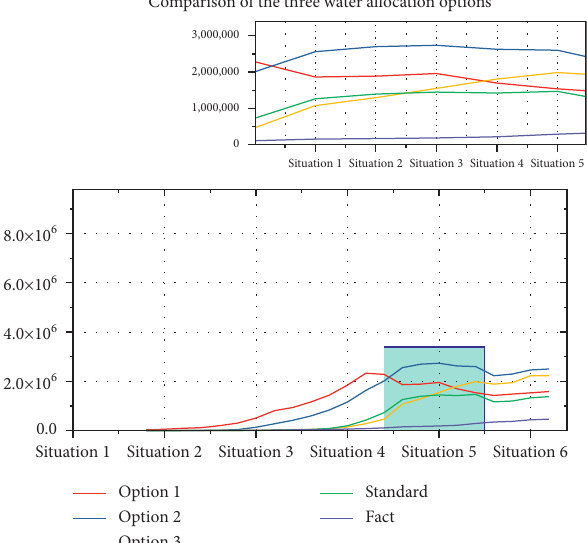
Figure 7: Comparison of the three water allocation options.